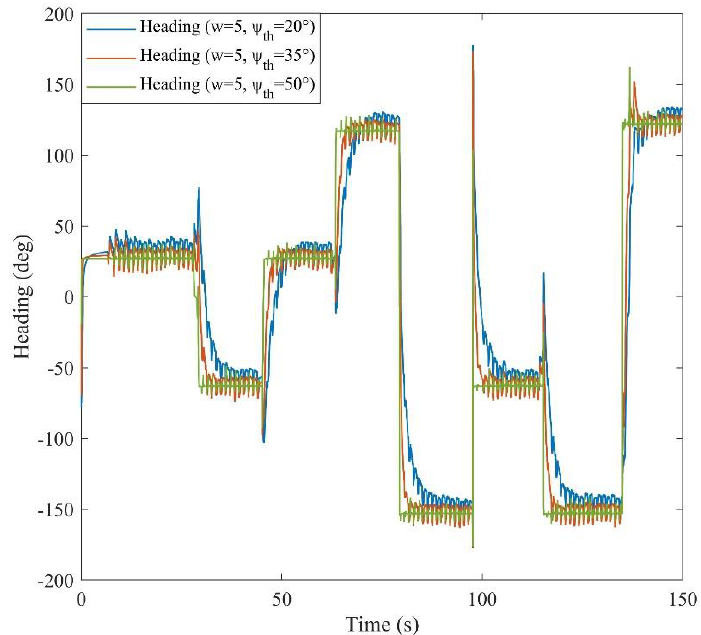
Figure 9. Estimated heading for various window sizes and threshold values.